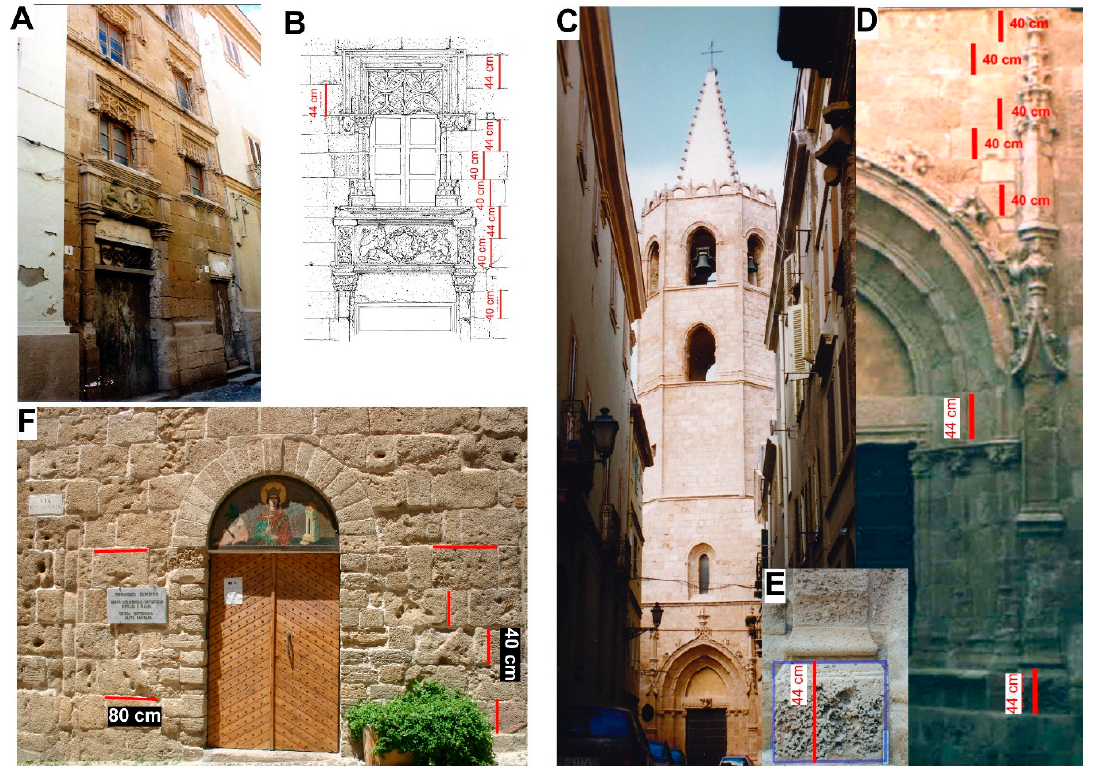
Figure 13. Alghero buildings of the 14th to the first half of 16th Centuries. ( A ) Façade of the Palazzo Machin, ( B ) Sketch of the façade of the Palazzo Machin enhancing di-dimension of used blocks. ( C ) Bell tower of the Alghero Cathedral. ( D ) Dimension of blocks used for the Bell tower and their size. ( E ) Detail of a block used for the left entrance pillar of the Bell Tower. ( F ) Dimension stones of the St. Barbara Church.